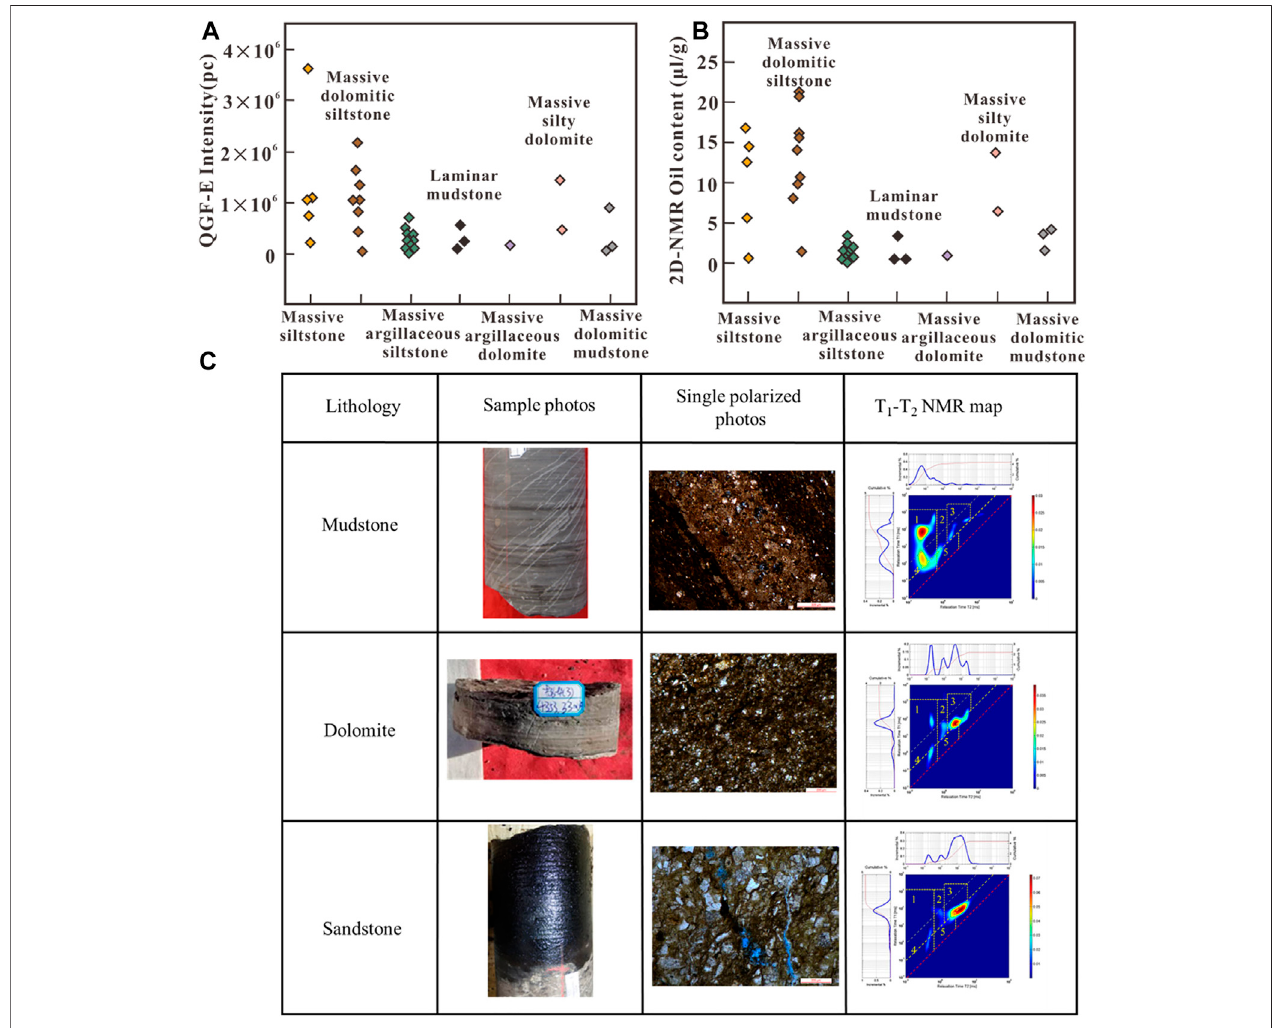
FIGURE 11 | Oil content analysis of different lithofacies. (A) The relationship between lithofacies and QGF-E intensity. (B) The relationship between lithofacies and 2D-NMR oil content. (C) The relationship between lithofacies and 2D NMR map.